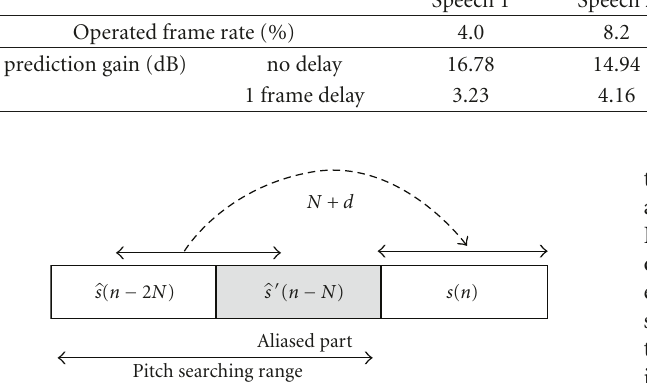
Figure 2: Pitch searching range of